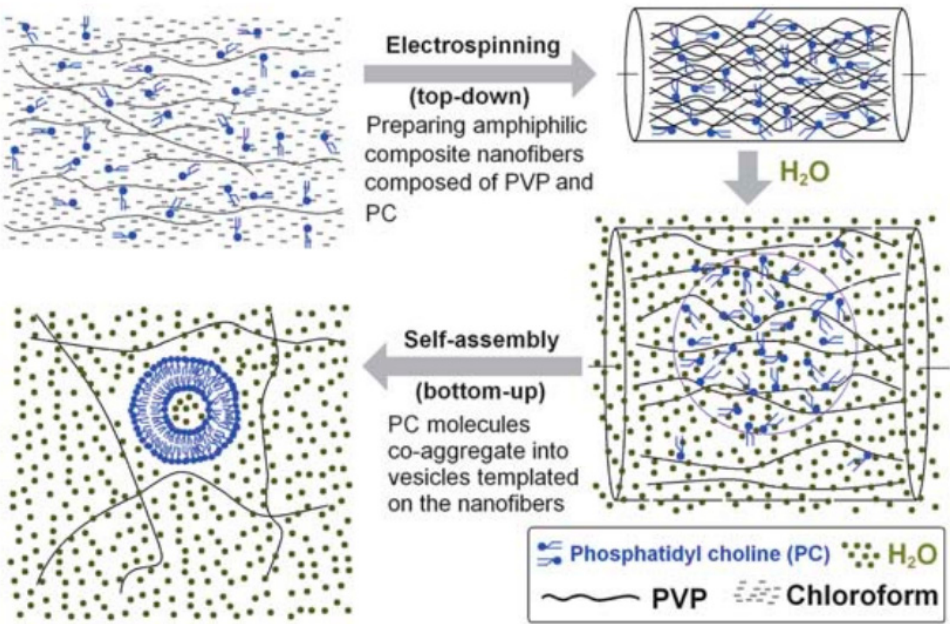
Figure 3. Schematic diagram illustrating the self-assembly of liposomes from PVP-PC electrospun nanofibers. Reprinted with permission from [97] the Royal Society of Chemistry; permission conveyed through the Copyright Clearance Center, Inc.